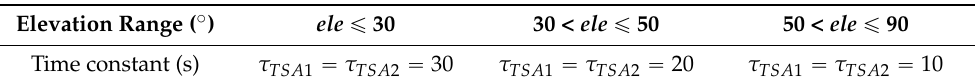
Table 3. Time constant of TSA for different elevation groups chosen depending on 31 satellites being visible.